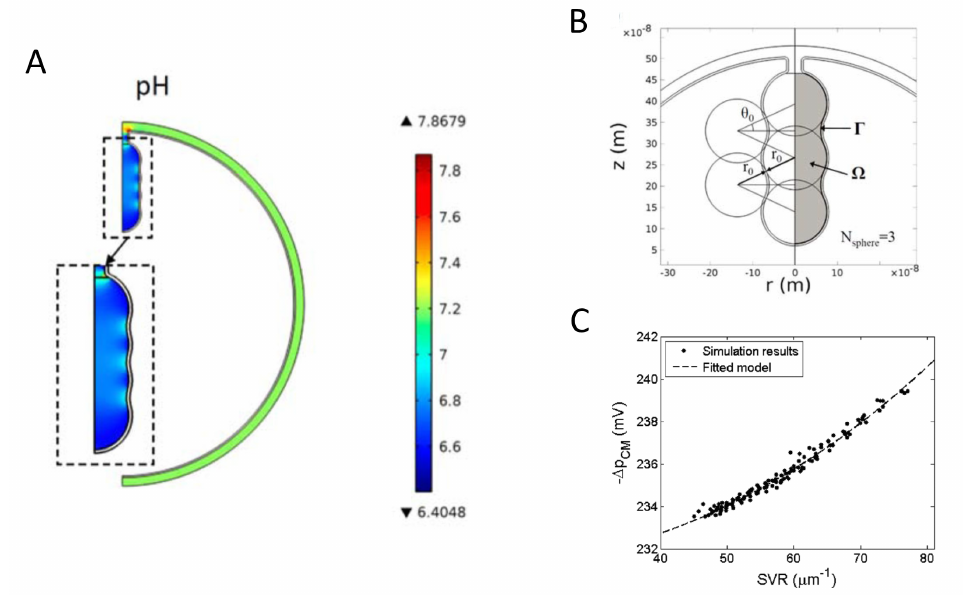
Figure 2. Mitochondrial model with a single cristae. ( A ) Proton concentration distribution (expressed as pH) in the inner mitochondrial space (cristae and non-cristae portions). ( B ) Geometry used to investigate the effect of detailed cristae morphology. ( C ) Effect of the surface-to-volume ratio (SVR) on the average PMF on the cristae membrane ( ∆ p CM ). Reproduced with permission from Song et al. [34], Phys. Rev. E; published by the APS,